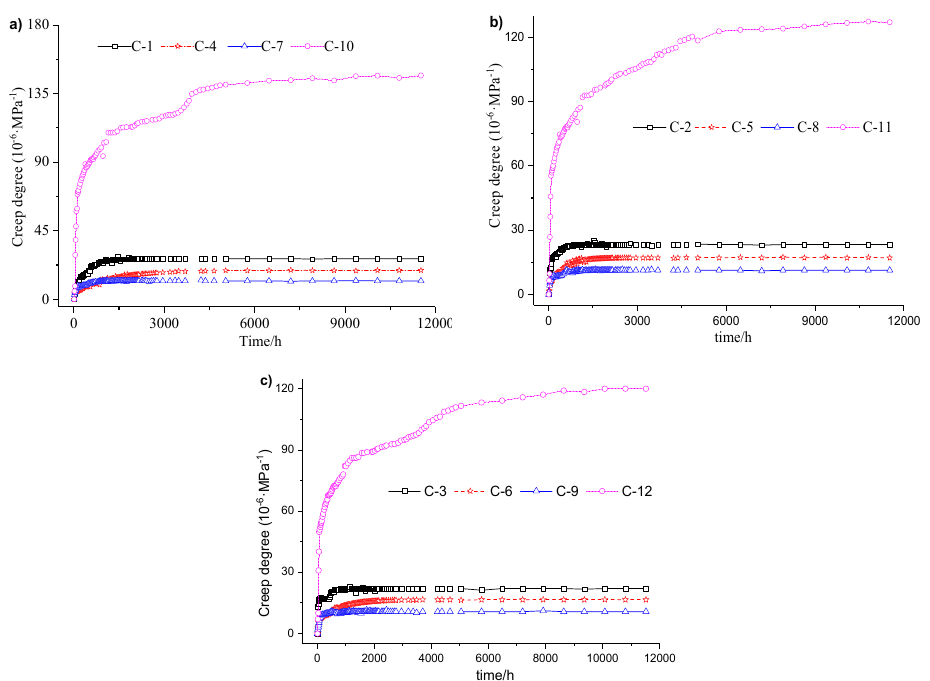
Figure 4. Creep of concrete with different lateral restraint conditions: ( a ) expansion agent dosage is 4%; ( b ) expansion agent dosage is 8%; ( c ) expansion agent dosage is 12%. Table 7. The effects of lateral restraint and different steel ratios on the creep of concrete. Time